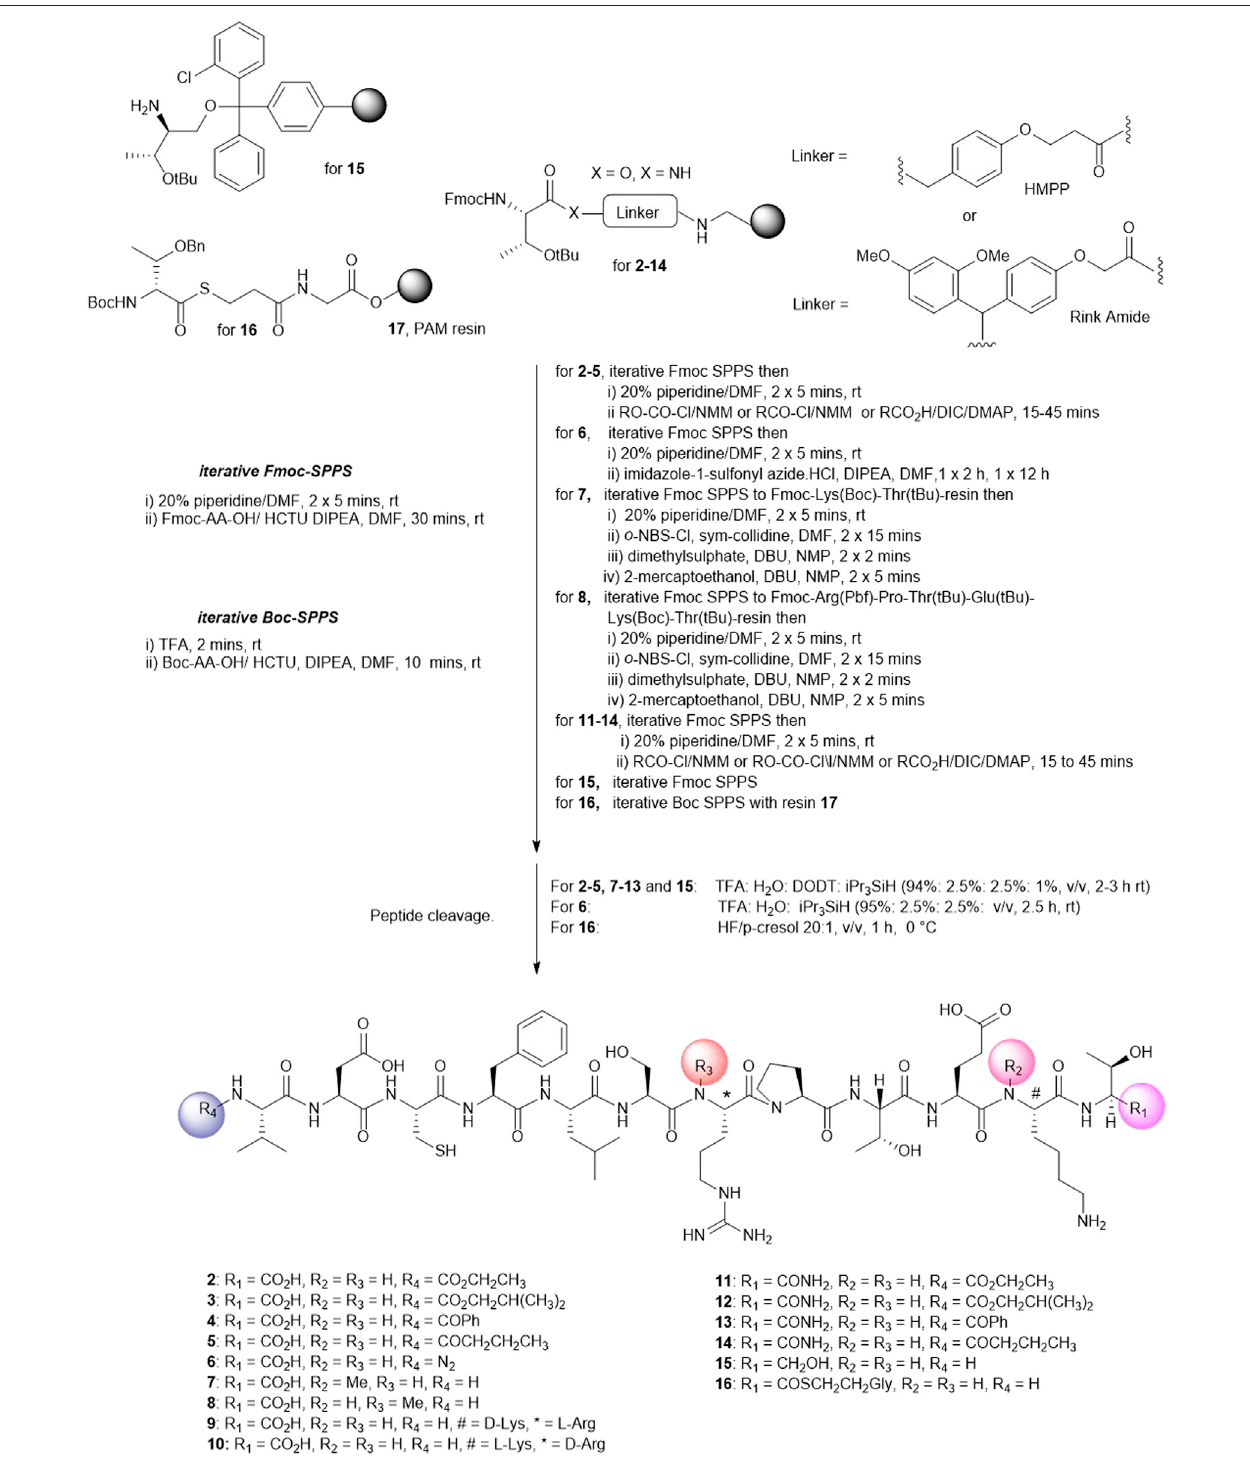
FIGURE 2 | Solid phase synthesis strategy to prepare linear Peptide5 analogues modi fi ed at the C- and Ntermin and D and N-Me variants.